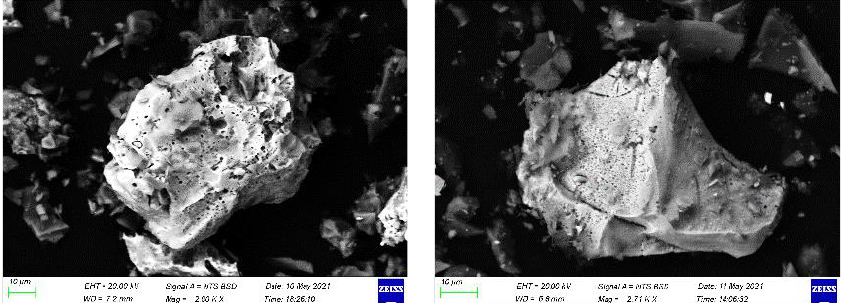
Figure 17. SEM images of leached pitted pyrite particles in 3 M nitric acid at a temperature of 65 °C. The pyrite samples were examined with XRD before and after leaching in 3 M nitric